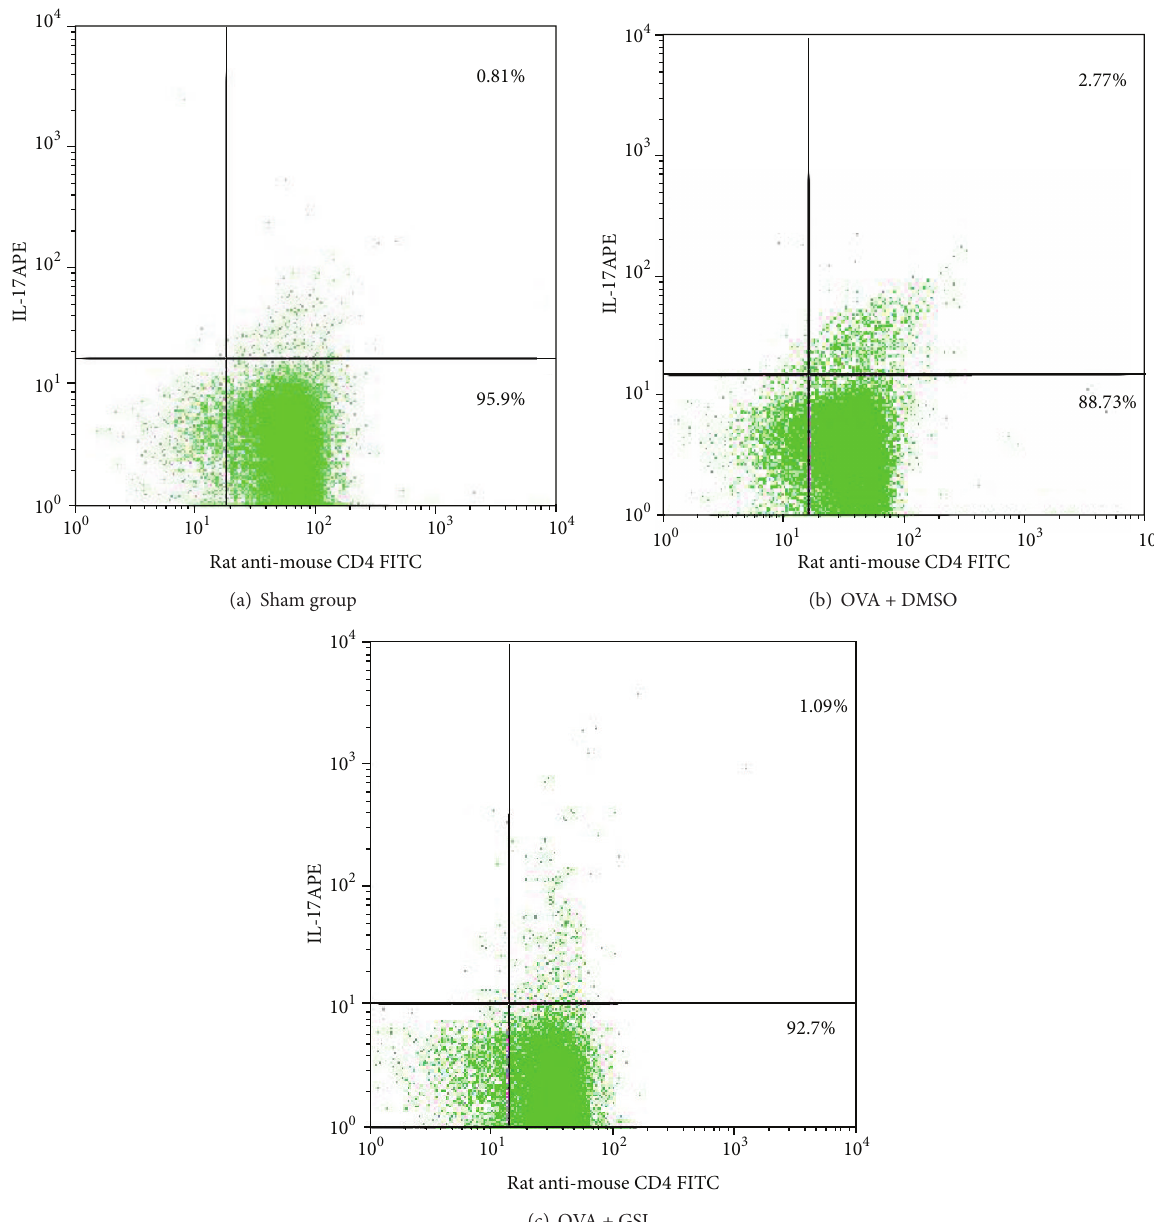
Figure 4: GSI administration resulted in reduced Th17 cell expansion. BALB/C mice were sensitized i.p. with OVA and challenged with OVA in the presence and absence of GSI. Splenic CD4 + T cells were isolated by magnetic cell sorting. Th17 cells were examined by IL-17A staining and data were analyzed by flow cytometry. Dot plots show as percent of cells positive for CD4 and IL-17A staining. Graphs representative of one of eight